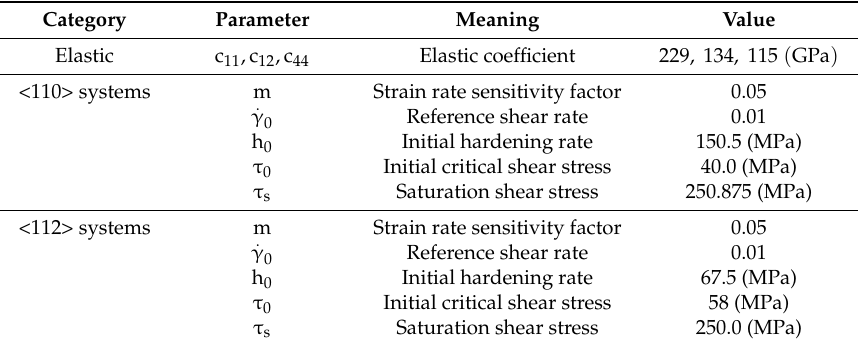
Table 2. Material constants and parameters in current CP-FEM model.